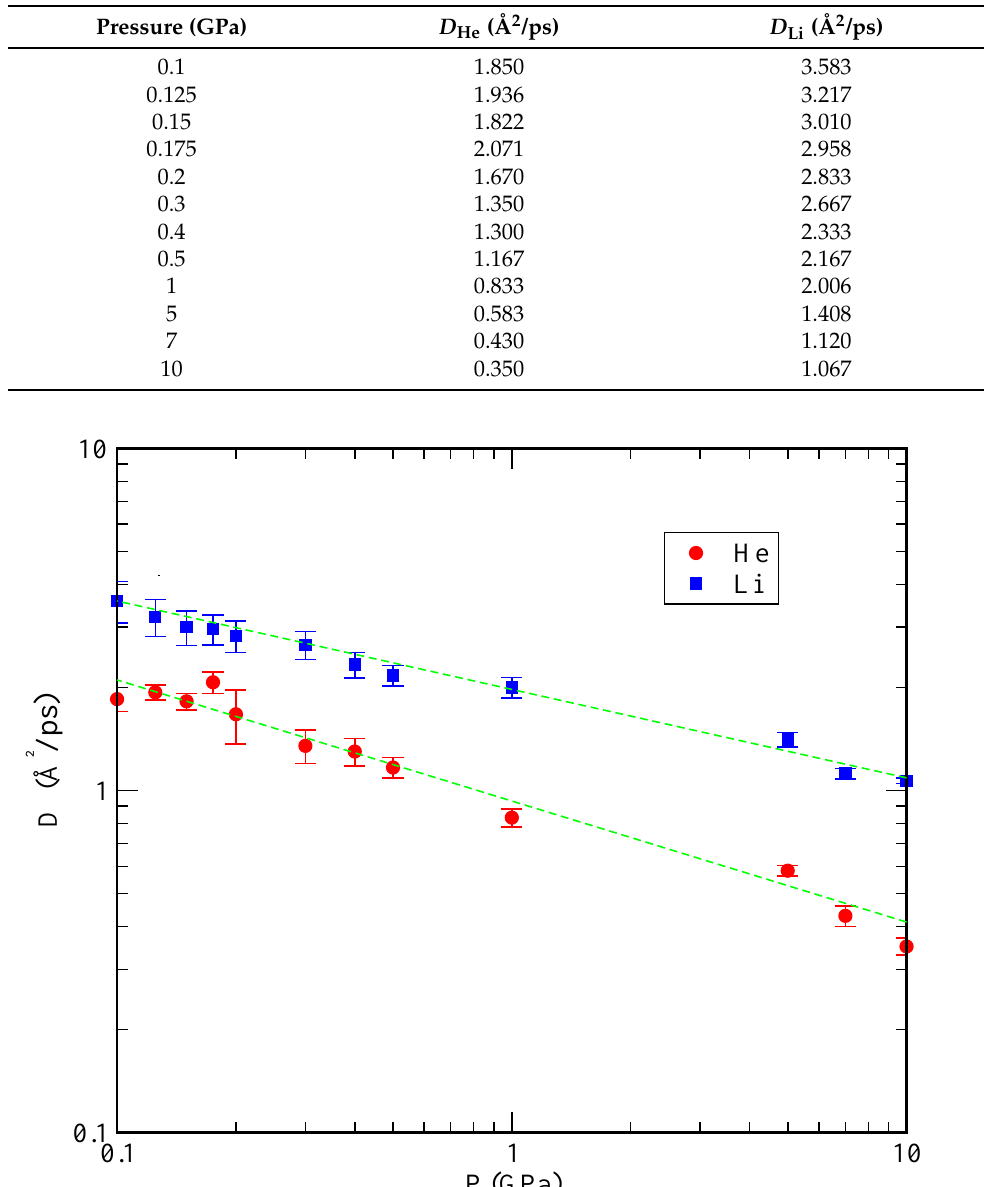
Table 4. Diffusion coefficients of lithium and helium at 843 K as a function of the pressure.